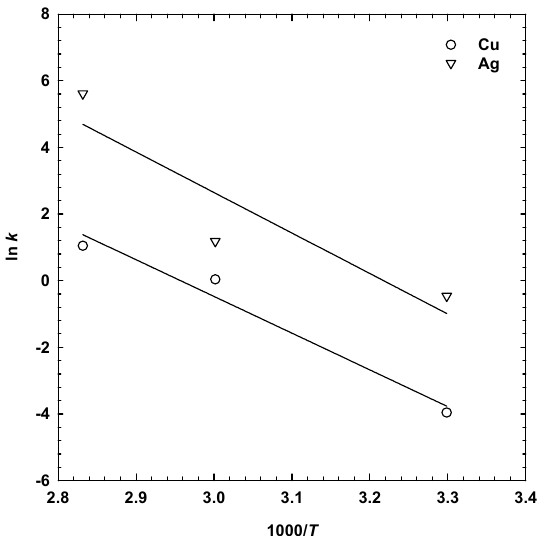
Figure 9. Arrhenius plot for the dissolution of copper and silver from the seafloor massive sulphides (SMS) (1 M H 2 SO 4 , 13.5 g/dm 3 MnO 2 , 1 M NaCl, 30 g/dm 3 SMS, 300 rpm).